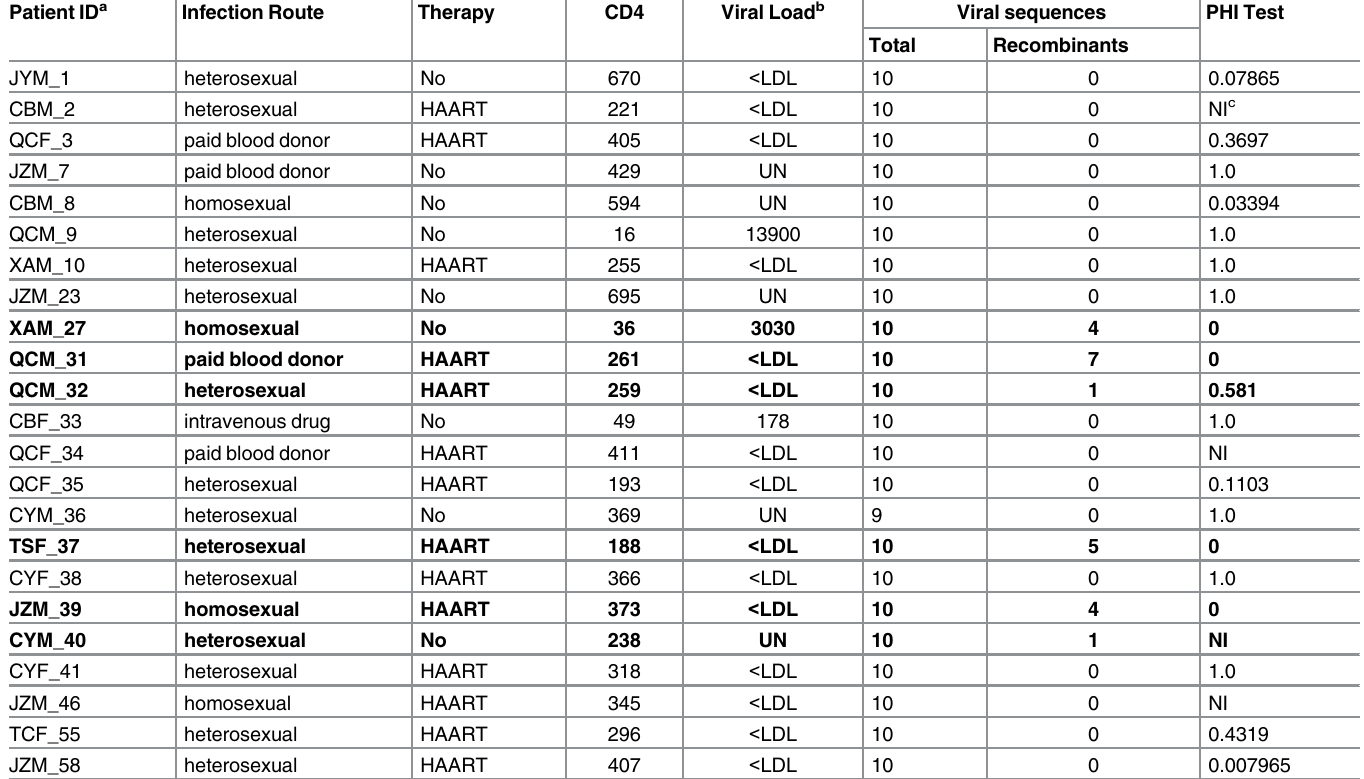
Table 1. Number of patients, patient ID, transmission route, CD4 count, HIV viral load, number of clones, and Phi test for each patient analyzed in this study. Patient ID a